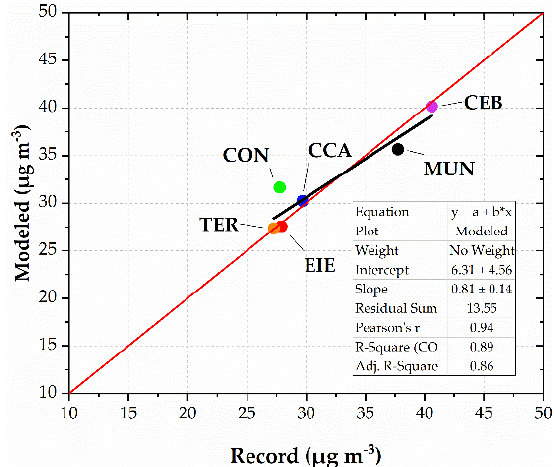
Figure 6. Maximum 24 h mean PM 2.5 records and modeled concentrations from 31 December 2021 to 1 January 2022. Dots and nomenclature correspond to the six stations measuring PM 2.5 concentrations. The black line indicates the linear fit between records and modeled values. The red line corresponds to a perfect fit.